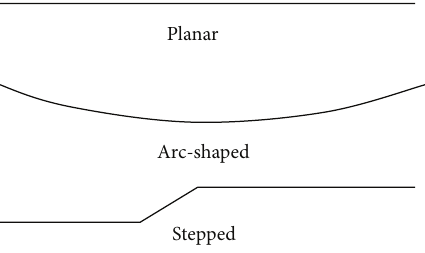
Figure 7: Generalized models of macroscopic